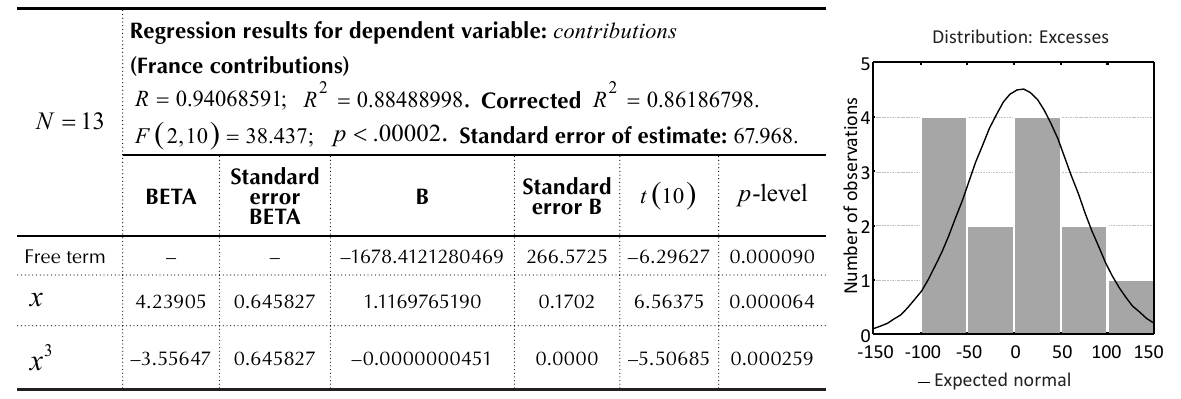
Table 5b. The results of regression for contributions of the members of the Fonds de Guarantee des Dépôts et de Résolution (FGDR) (France) ( ) c from its volume ( )